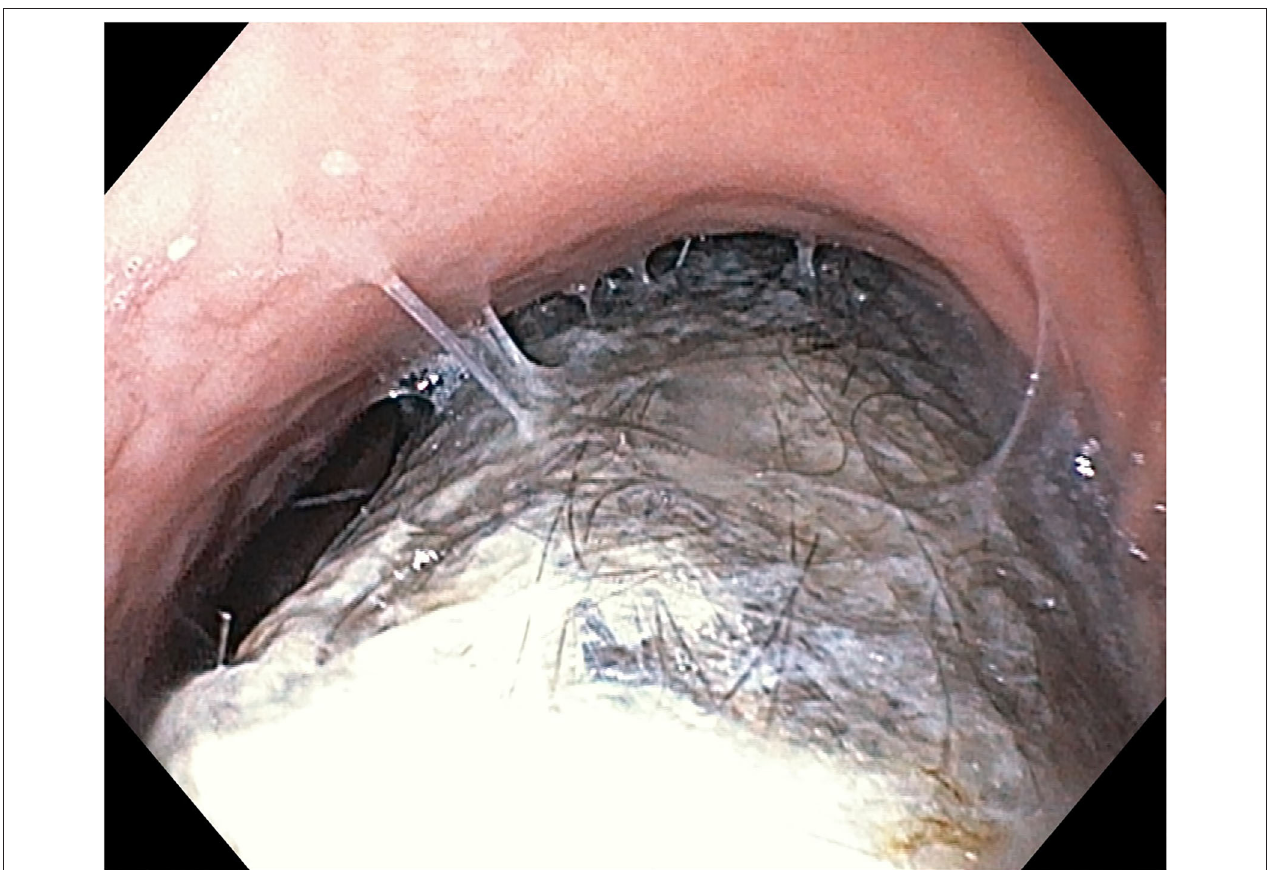
FIGURE 1 | Endoscopic aspect of trichobezoar—at the level of gastric